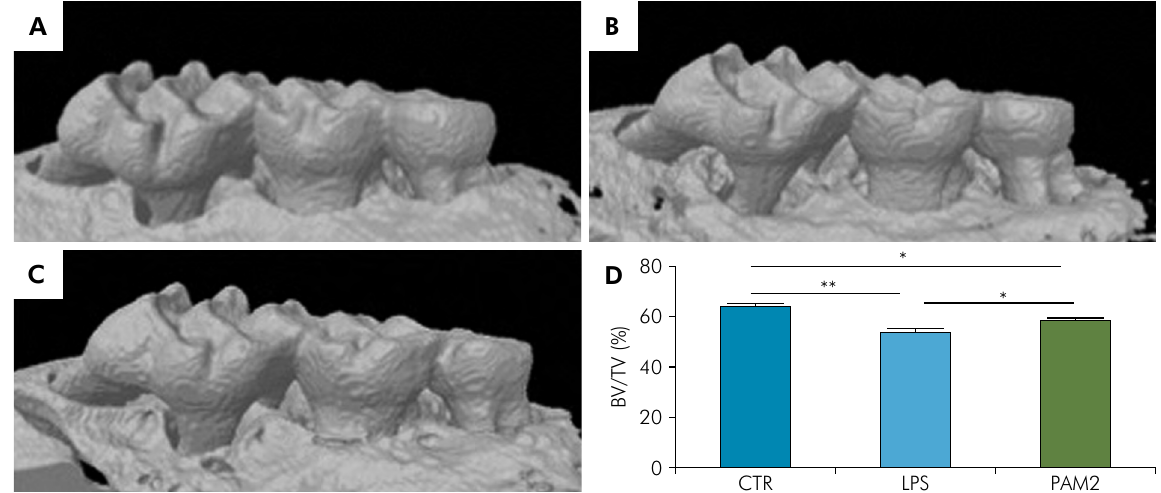
Figure 1. Microtomographic analysis of alveolar bone. (A-C): CTR group injected with saline solution (n = 7); LPS group injected with 5 μ g LPS (n = 7); and PAM2 group injected with 5 μ g PAM2 (n = 7) three times a week, for 24 days, in the gingival papilla in the palatal aspect, between the first and second molars, respectively; (D): Quantification of BV/TV in the maxilla of all